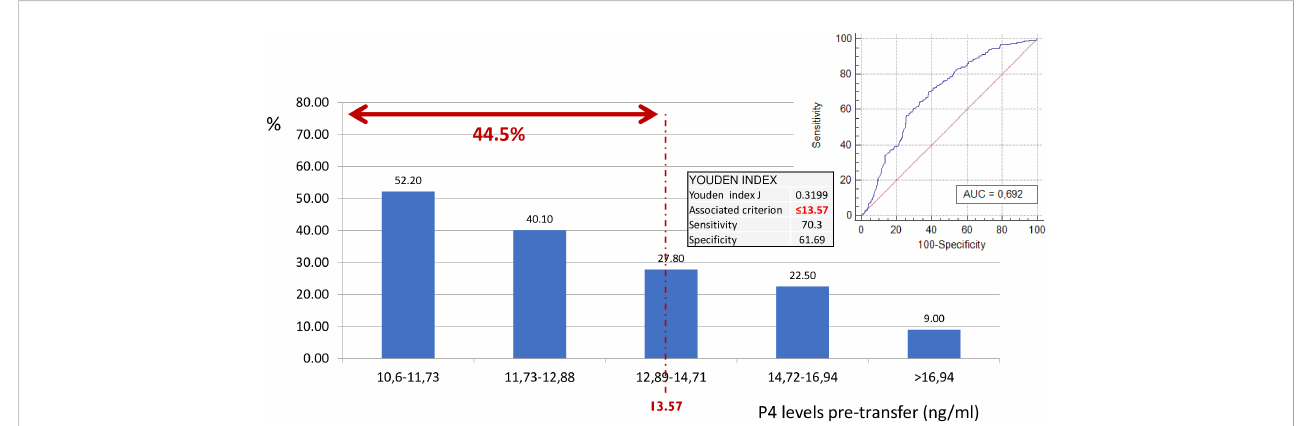
FIGURE 2 Probability of having progesterone levels < 10.6 on day of pregnancy test according to pre-transfer progesterone levels. ROC curve. Classi fi cation of low P on the day of hCG. Considering the P4 value on the day before ET. As a result of this ROC curve, a cutoff point of 13.57 ng/ml was selected with speci fi c sensitivity and speci fi city values. Therefore, 44.5% of the cycles with progesterone ≤ 1 3.57 ng/ml, despite being “ high ” , have a low progesterone value on the day of hCG. ROC, receiver operating characteristic; hCG, human chorionic gonadotropin; P4, progesterone; ET, embryo